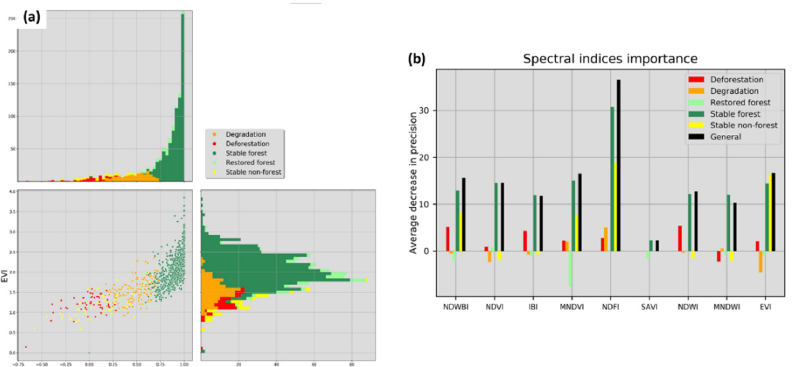
Figure 13. ( a ) Scatterplot of two spectral indices (EVI and NDFI); the points represent the values